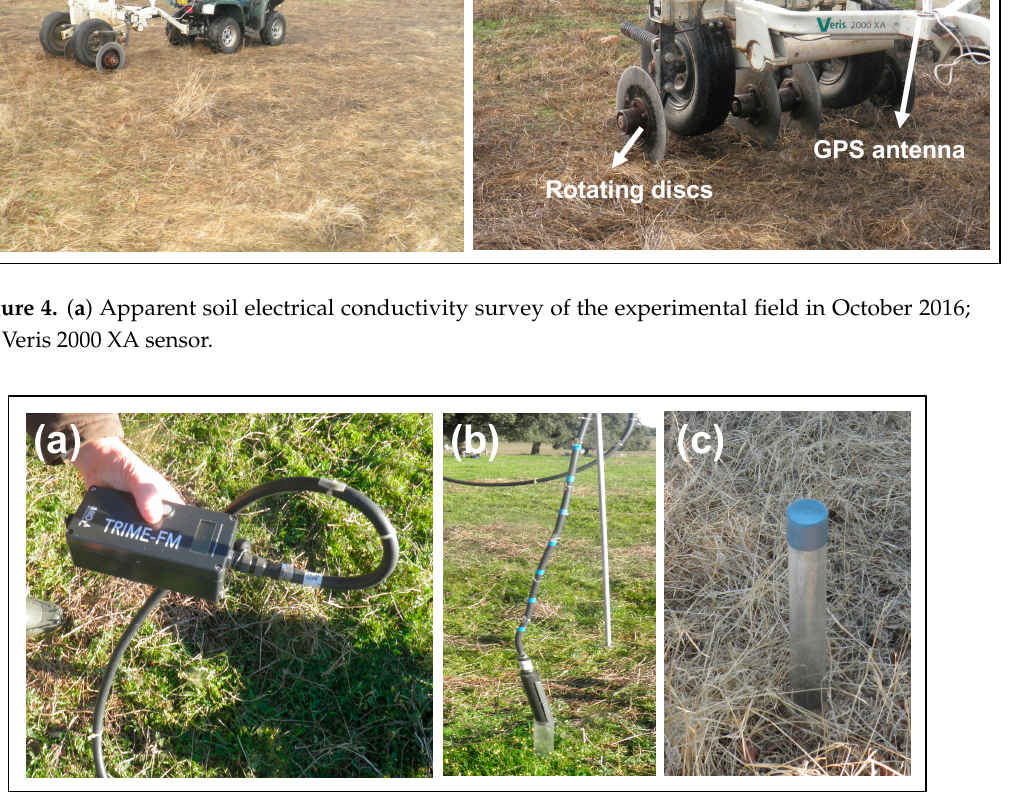
Figure 4. ( a ) Apparent soil electrical conductivity survey of the experimental field in October 2016; ( b ) Veris 2000 XA sensor.